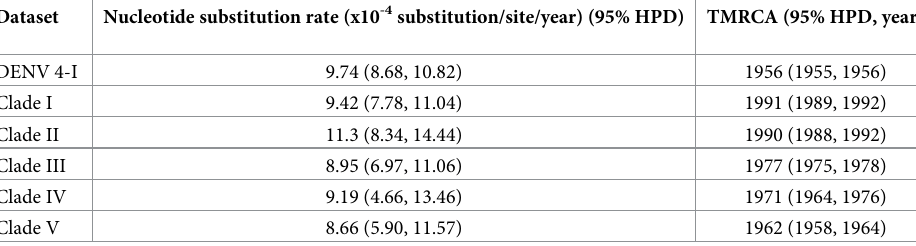
Table 1. Nucleotide substitution rates and divergence times for the E-gene from different datasets. Dataset